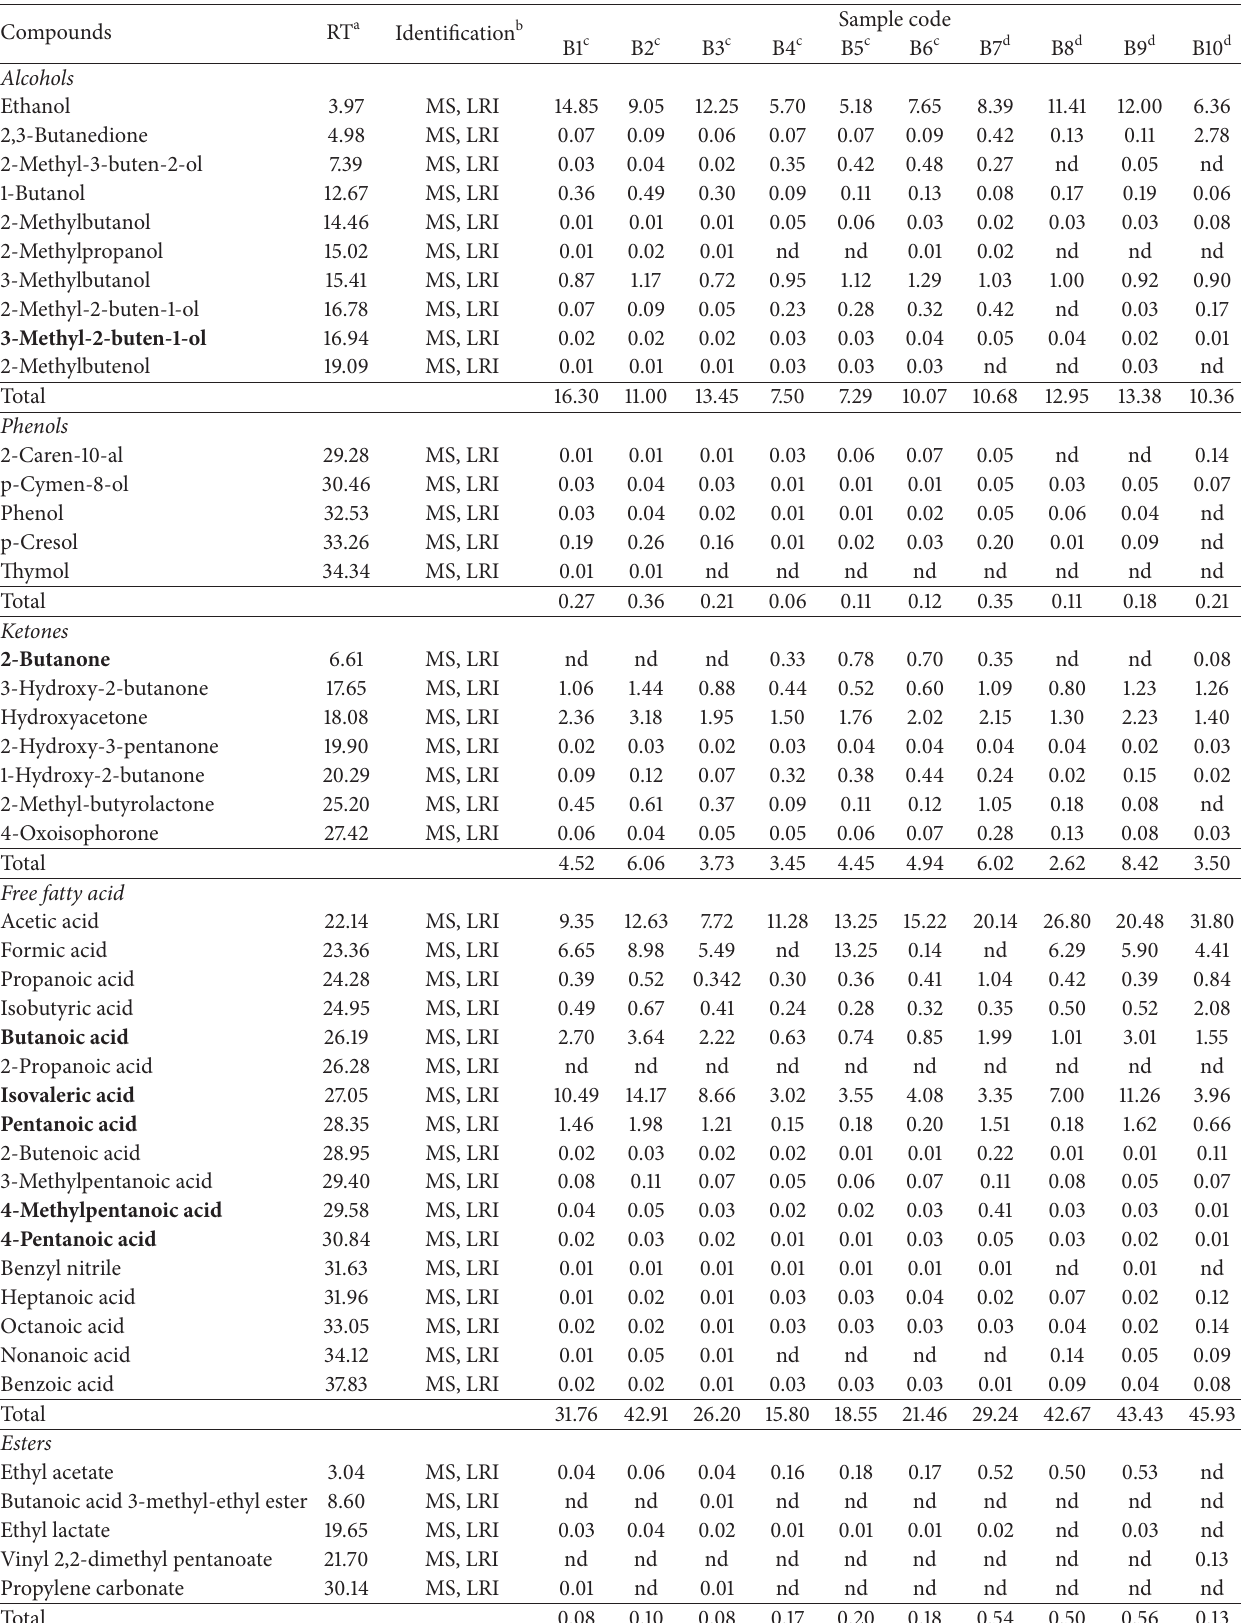
Table 4: Volatile compounds identified in investigated honey samples expressed as percentages. B1–B6: buckwheat honey from Italy (Teglio- Valtellina); B7: buckwheat honey from Russia; B8 and B9: buckwheat honey from Poland; B10: Buckwheat honey from